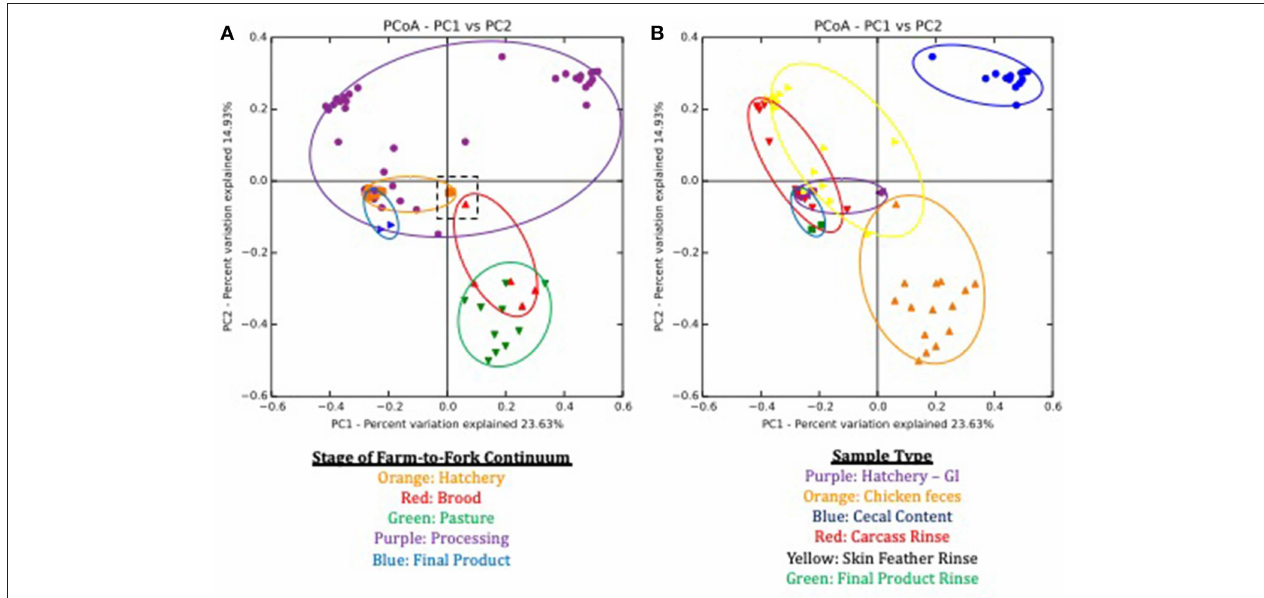
FIGURE 2 | Principle Coordinate Analysis (PCoA) plots based on Bray Curtis dissimilarities of microbiomes during the lifespan of a pasture-raised broiler flock. (A) Sample separation based on stage of farm-to-fork continuum, with each stage being assigned a different color. Symbols represent different samples from a given stage, and the ovals encompass the area of the graph that covers all of the samples for a given stage. The dashed black box in the middle of the graph highlights the GIT and feces samples that occur within the first day post-hatch. (B) Sample separation based on the sample type, with each sample being assigned a different color. Symbols represent different samples from a given sample type, and the ovals encompass the area of the graph that covers all of the samples for a given sample type.